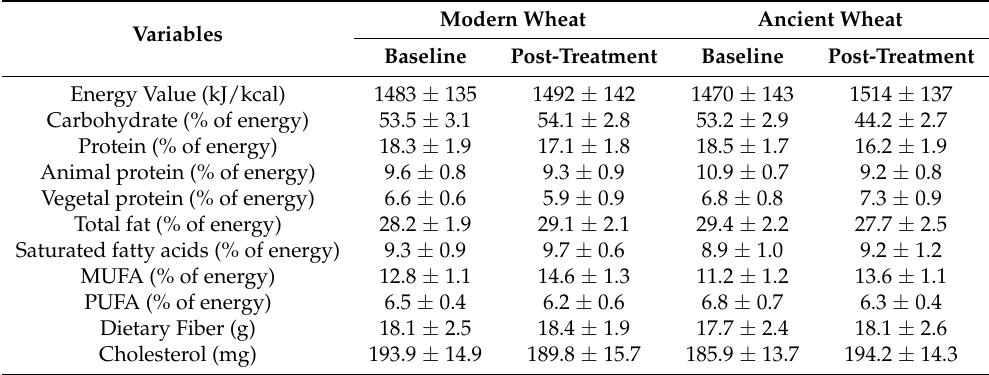
Table 4. Daily energy and nutrient intakes assessed by patient food diaries, before and after the treatment periods, expressed as mean ± standard deviation.